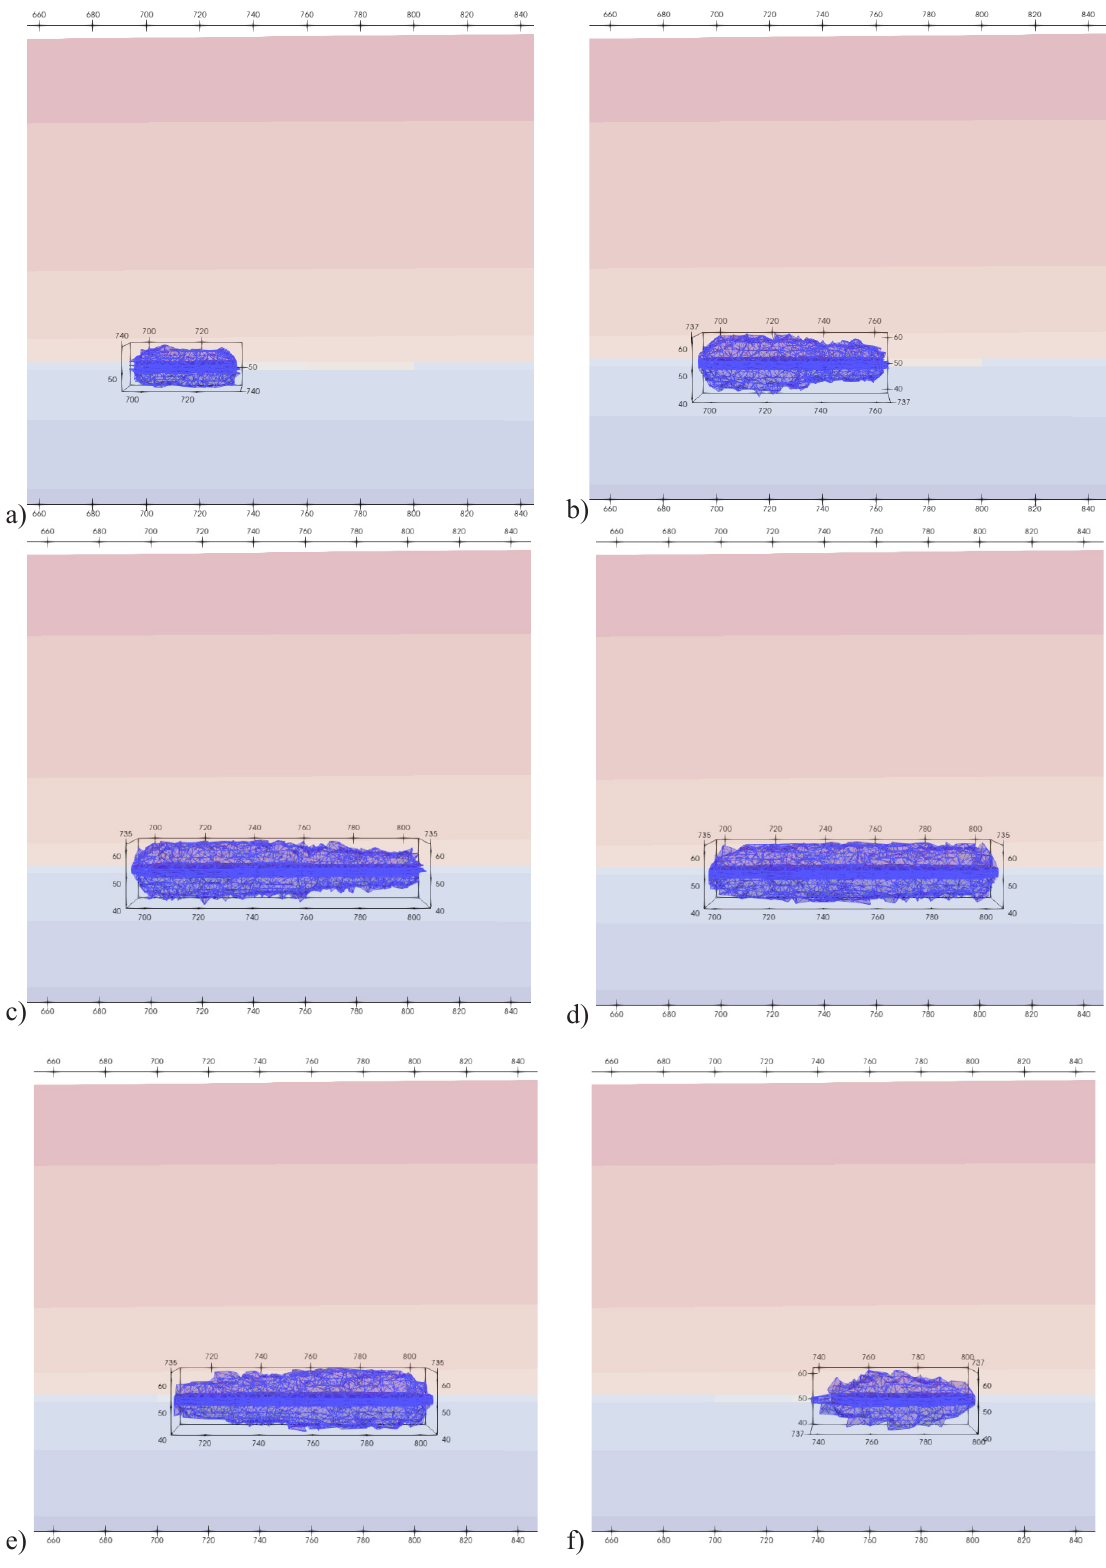
Figure 7: Water vapour presence in cross-section at times a) start, b) 0.5 year, c) 1 year, d) 1.5 year, e) 2 years f) 2.5